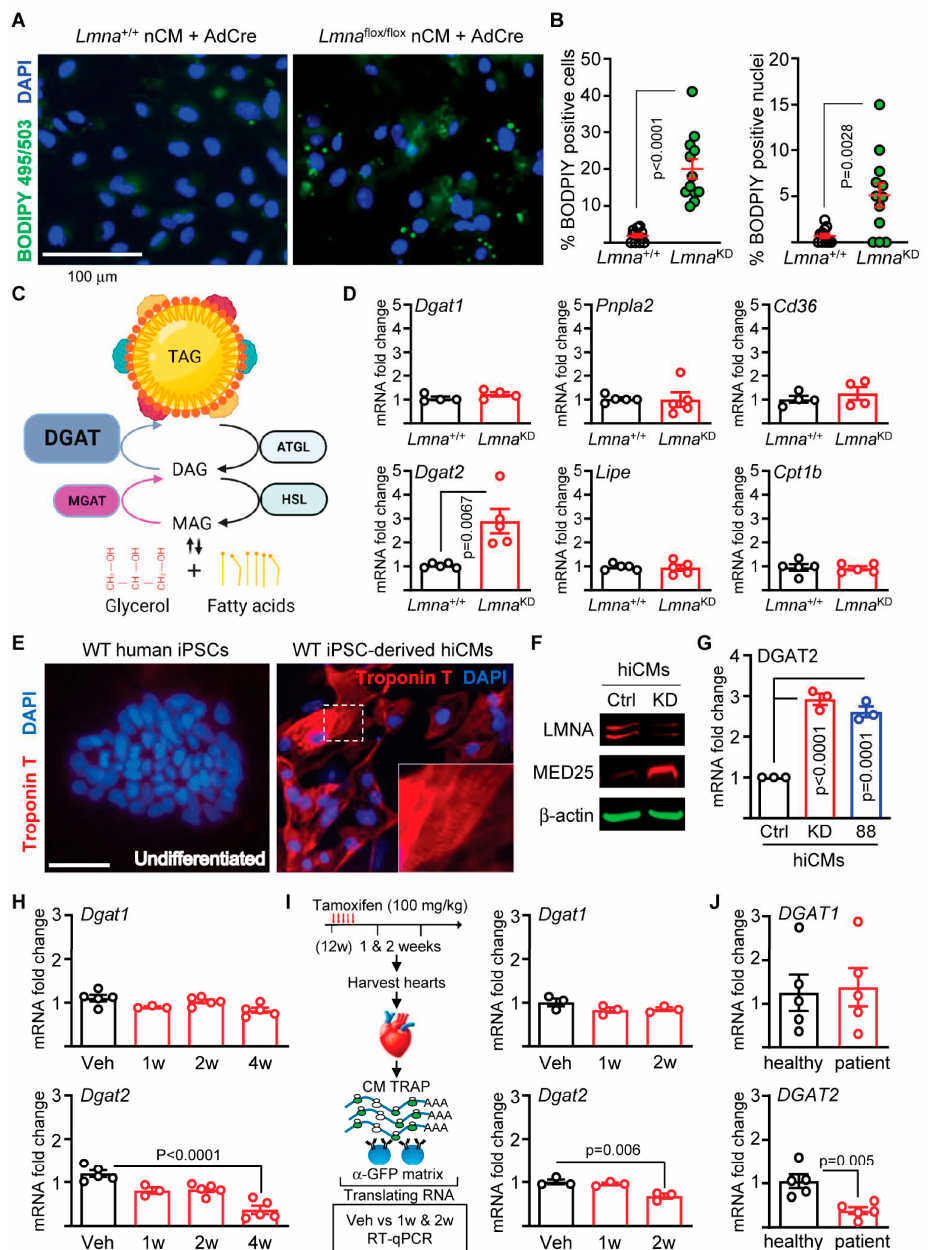
Figure 2. Increased DGAT2 mRNA expression in response to lamin A/C depletion in neonatal and embryonic but not in adult CMs. ( A ) nCMs isolated from Lmna + /+ and Lmna flox/flox mice ( Lmna KD) infected with AdCre and cultured on 50 kPa matrix for 48 h, after which they were stained with